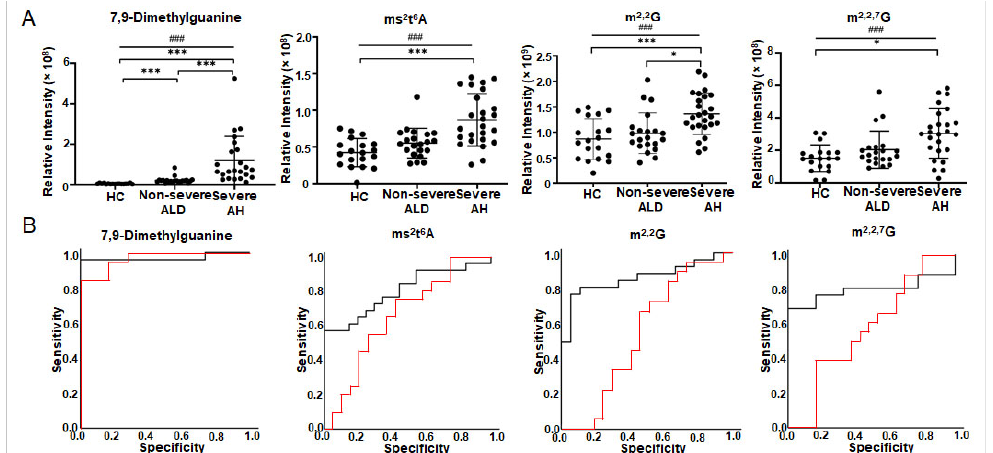
Figure 2. Modified nucleosides/bases with significant abundance change in urine detected by tar- geted metabolomics using SPE RPC-MS. ( A ) is the abundance changes of modified nucleosides/bases in the urine of patients. ( B ) shows ROC analysis results. The red curve shows the ROC analysis results of HC vs. non-severe ALD. The AUC of 7,9-dimethylguanine is 0.968, p < 0.001 and 95% CI = 0.921–1.000. The AUC of ms 2 t 6 A is 0.658, p = 0.092 and 95% CI = 0.483–0.833. AUC of m 2,2 G is 0.526, p = 0.784 and 95% CI = 0.332–0.721. AUC of m 2,2,7 G is 0.585, p = 0.378 and 95% CI = 0.397–0.772. The black curve shows the ROC analysis result of non-severe ALD vs. severe AH. The AUC of 7,9-dimethylguanine is 0.969, p < 0.001 and 95% CI = 0.909–1.000. The AUC of ms 2 t 6 A is 0.796, p = 0.001 and 95% CI = 0.665–0.927. AUC of m 2,2 G is 0.856, p < 0.001 and 95% CI = 0.740–0.971. AUC of m 2,2,7 G is 0.791, p = 0.001 and 95% CI = 0.645–0.937. One-way ANOVA was used for the statistical significance test with the Tukey method for post-hoc analysis and the Benjamini and Hochberg method for multiple test correction, * q < 0.05; *** q < 0.001. The p -value scale of the linear-by-linear association test is ### p < 0.001. ms 2 t 6 A, 2-methylthio- N 6 -threonylcarbamoyladenosine; m 2,2 G, N 2 , N 2 -dimethylguanosine; m 2,2,7 G , N 2 , N 2